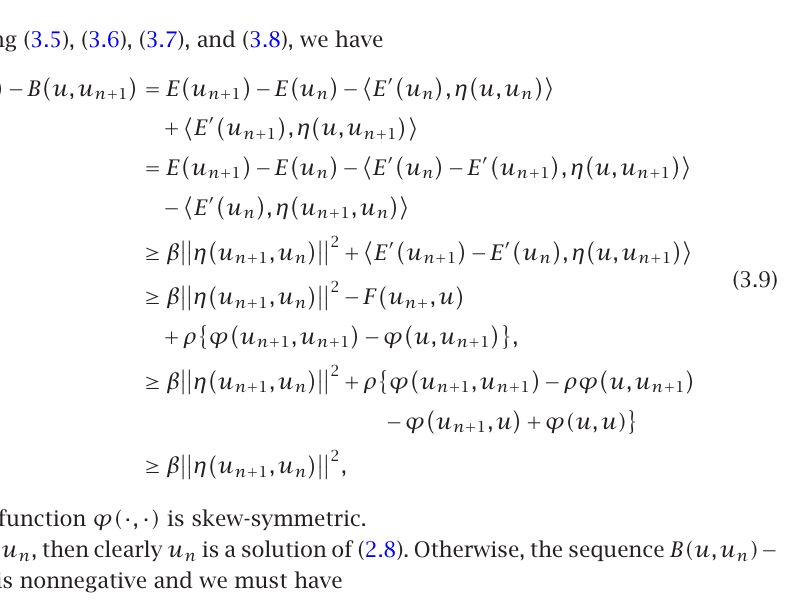
∈ H , calculate the approximate solution u n + 0